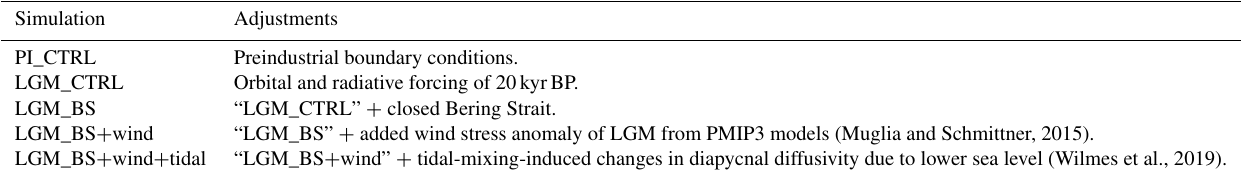
Table 1. List of simulation setups. Simulation Adjustments PI_CTRL Preindustrial boundary conditions. Orbital and radiative forcing of